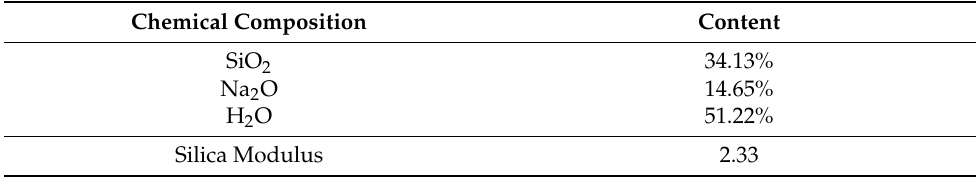
Table 4. Chemical composition of